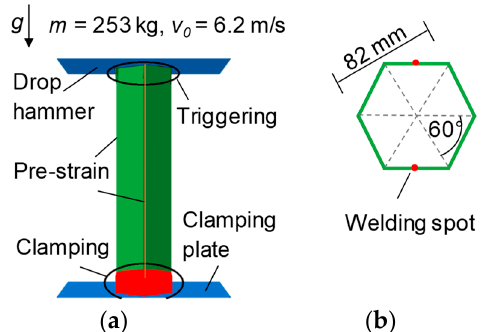
Figure 4. ( a ) Crash box geometry with boundary conditions of the FE simulation; ( b ) Hexagonal profile in mm with marked plane where the half hexagons were laser welded.